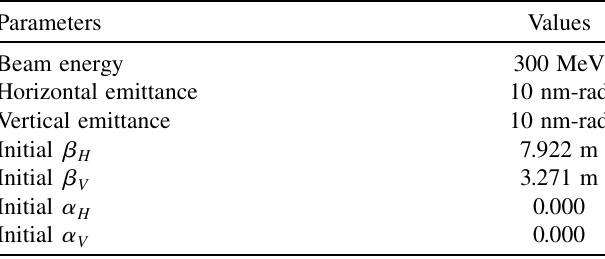
TABLE I. Optical parameters of bunch compressor.